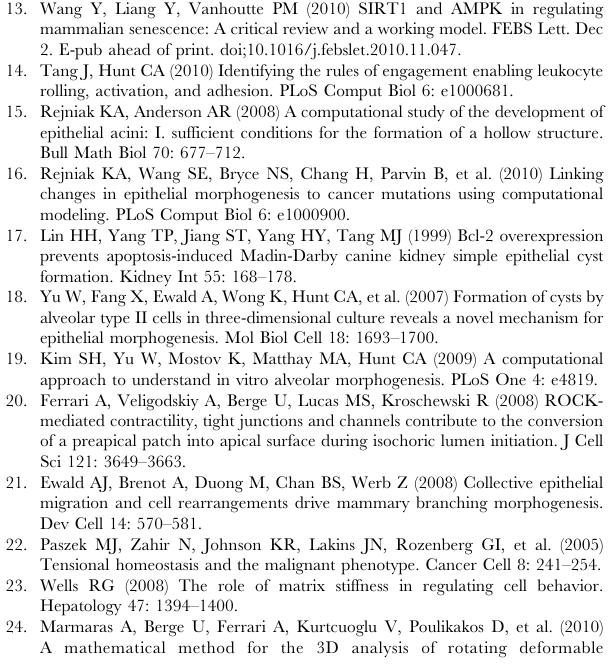
Table S4 Mean cell number per day for cysts grown in Matrigel. Numbers in bold italic are measured, mean values and non-bold numbers are projected values. Projected values were found by multiplying or dividing the measured mean values by the scaling factor of 1.56. During the first four days of growth, the number of cells increased by a constant factor of 1.4 to 1.8 per day, with a value of 1.56 minimizing the percent error between projected and measured mean values. Using that scaling factor, the number of cells at day 0 was estimated to be 2.1, indicating that some clustering took place within the Matrigel culture. To reflect this observation, ISMAs implemented CELL